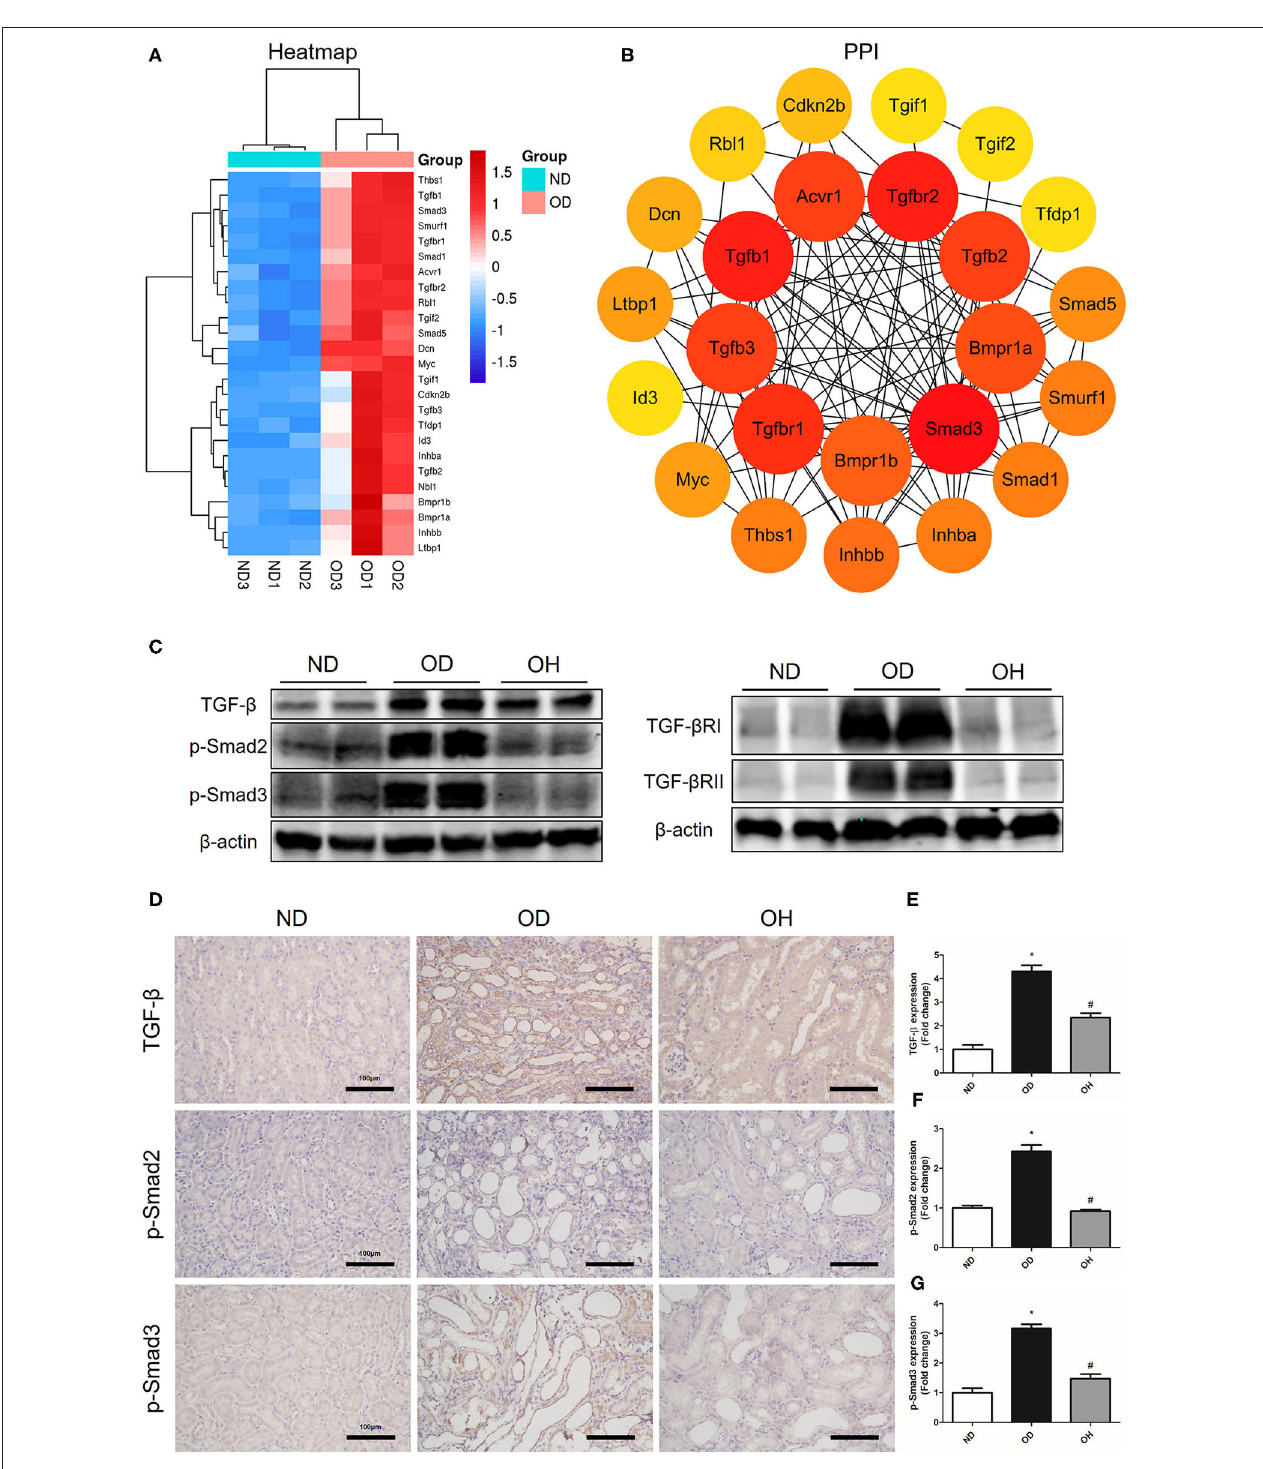
FIGURE 7 | HRW administration suppresses oxalate-induced TGF- β signaling pathway activation in mice. (A) Heatmap and hierarchical clustering showing DEGs enriched in the TGF- β signaling pathway between the OD and ND groups. (B) PPI network constructed by DEGs enriched in the TGF- β signaling pathway. (C) The protein expressions of TGF- β , TGF- β RI, TGF- β RII, p-Smad2, and p-Smad3 in kidneys of mice were detected by western blotting. (D) The protein expressions of TGF- β , p-Smad2, and p-Smad3 in kidneys of mice were detected by immunohistochemistry (Scale bar = 100 µ m). (E–G) Corresponding semiquantitative analysis of TGF- β , p-Smad2, and p-Smad3 immunohistochemistry staining. The results were expressed as mean ± SEM. Statistical comparisons were performed using a NewmanKeuls test (* p < 0.05 vs. ND group, # p < 0.05 vs. OD group).